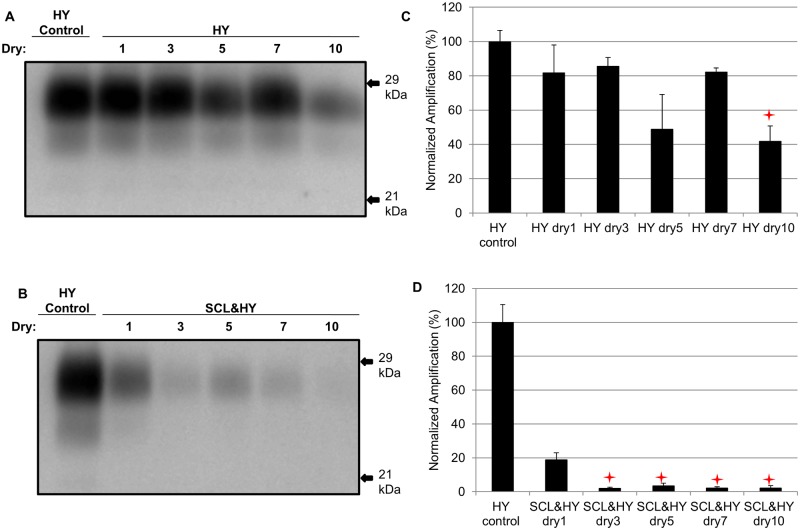
Sorption of HY to soil reduces the number of wet dry cycles that result in a decrease in PMCA conversion activity.Western blot (A and B) and quantification (C and D) of PMCA amplification (1 round) of HY PrPSc alone or adsorbed to SCL after 1, 3, 5, 7, and 10 serial rounds of drying and wetting. Migration of 29 and 21 kDa molecular weight marker is indicated on the right of the Western blot. Star indicates significant difference (p<0.05; n = 3) between multiple drying/wetting treated and single drying/wetting treated sample.